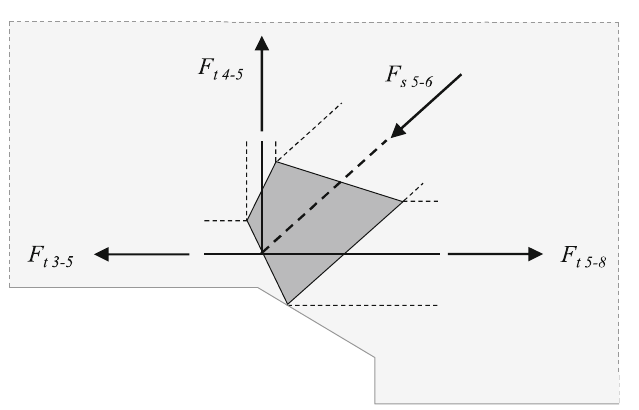
Fig. 10 Nodal zone 5 in specimen type B.